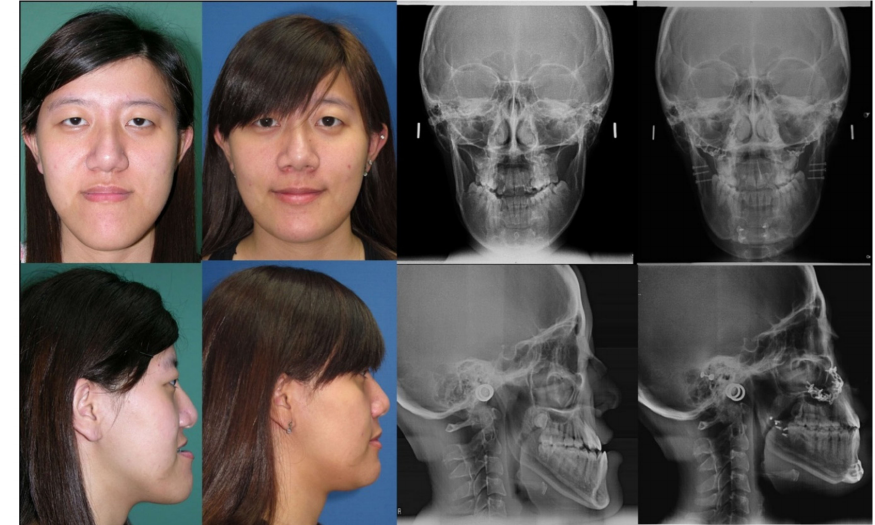
Figure 5. Case of an 18-year-old woman with a facial deformity characterized by a long face, mandibular protrusion, and chin deviation. She had a history of operation for biliary atresia during infancy, and liver cirrhosis and esophageal varices during adulthood. Her underlying conditions were adequately controlled. She underwent orthognathic surgery with Le Fort I, Wassmund osteotomy, bilateral sagittal split of the ramus, and genioplasty, with no postoperative intermaxillary immobilization. Her postoperative course was uneventful, and the results on occlusion and facial appearance were satisfactory. At follow-up 3 years after surgery, she appeared satisfied and reported psychosocial improvement. Patient provided written consent for the use of her